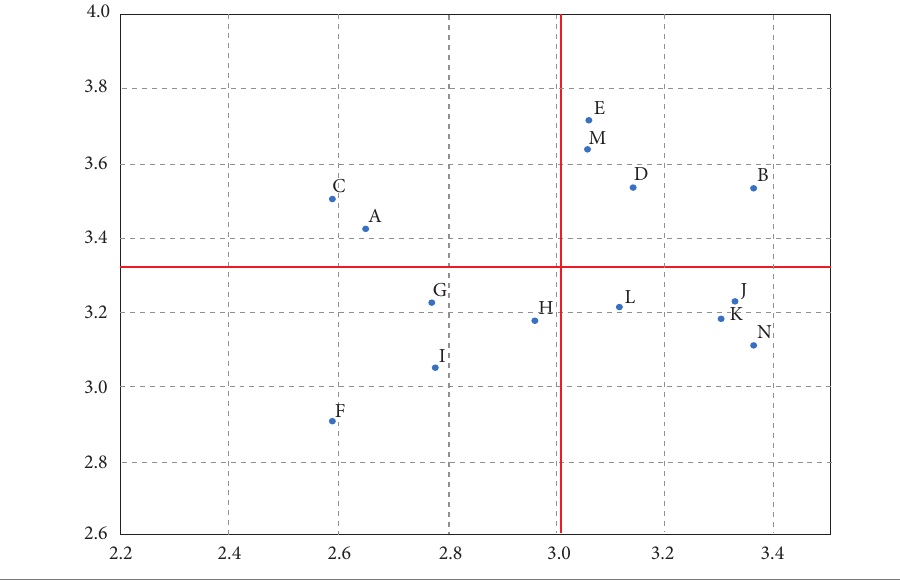
Fig. 15. The scatter diagram of parameters of relations of Ukrainian enterprises with the subcontractor/main contractor